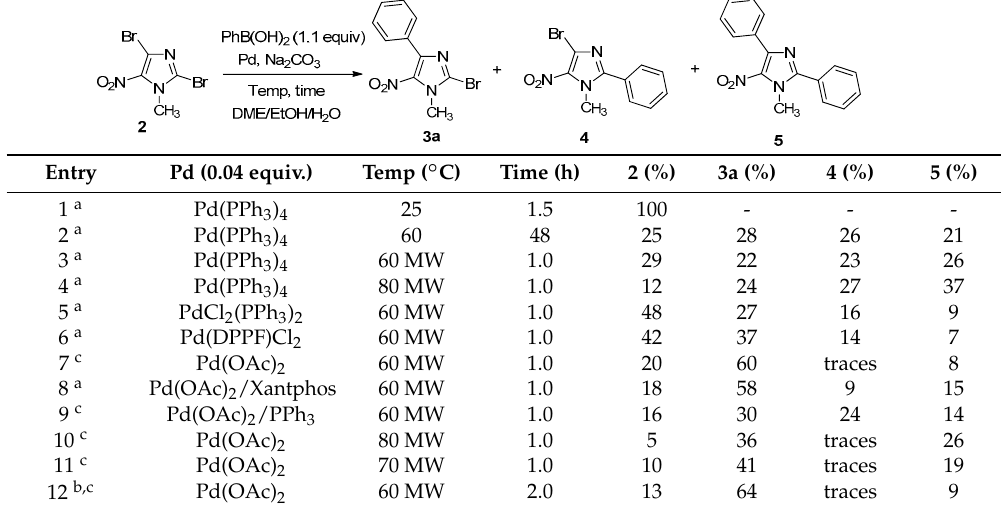
Table 1. Optimization of the regioselective Suzuki-Miyaura reaction.